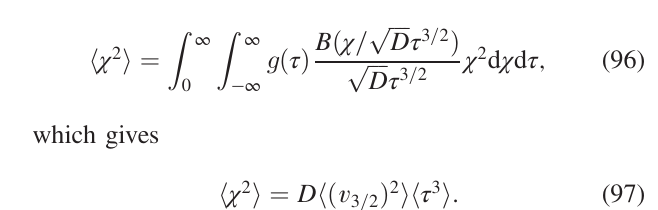
FIG. 11. Scaled mean-square displacement in the Lévy phase. In the simulations (filled circles), we used t ¼ 10 5 and averaged over 10 5 particles; to reduce fluctuations in the vicinity of the transition to the Gaussian phase, we averaged over trajectory times in the range 10 3 – 10 5 (last two points). The solid line is the prediction of Eq. (93).